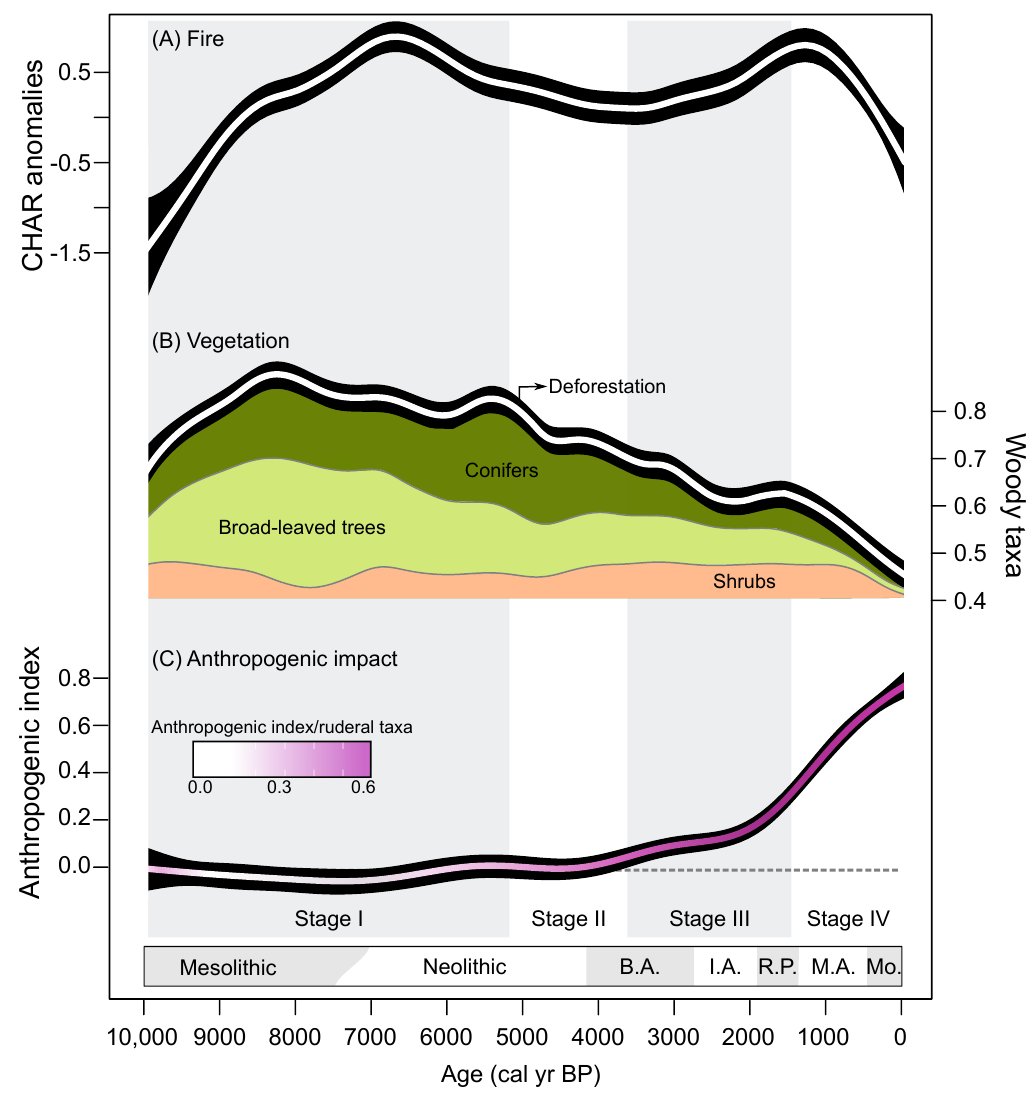
Figure 3. Holocene trends in fire, vegetation and anthropogenic impact in Temperate western Europe. ( A ) Regional biomass burning as estimated by a GAM applied to the charcoal data from the sub-region. ( B ) Vegetation openness inferred from woody-to-herbaceous pollen taxa. The relative proportion of conifers, broad-leaved trees and shrubs is shown. ( C ) Anthropogenic index as a function of time. The pink shading represents the total anthropogenic index-to-ruderal taxa ratio. The arrow shows the onset of pronounced deforestation depicted in Figure 7. In all cases, the black shading depicts 95% confidence intervals for the estimated